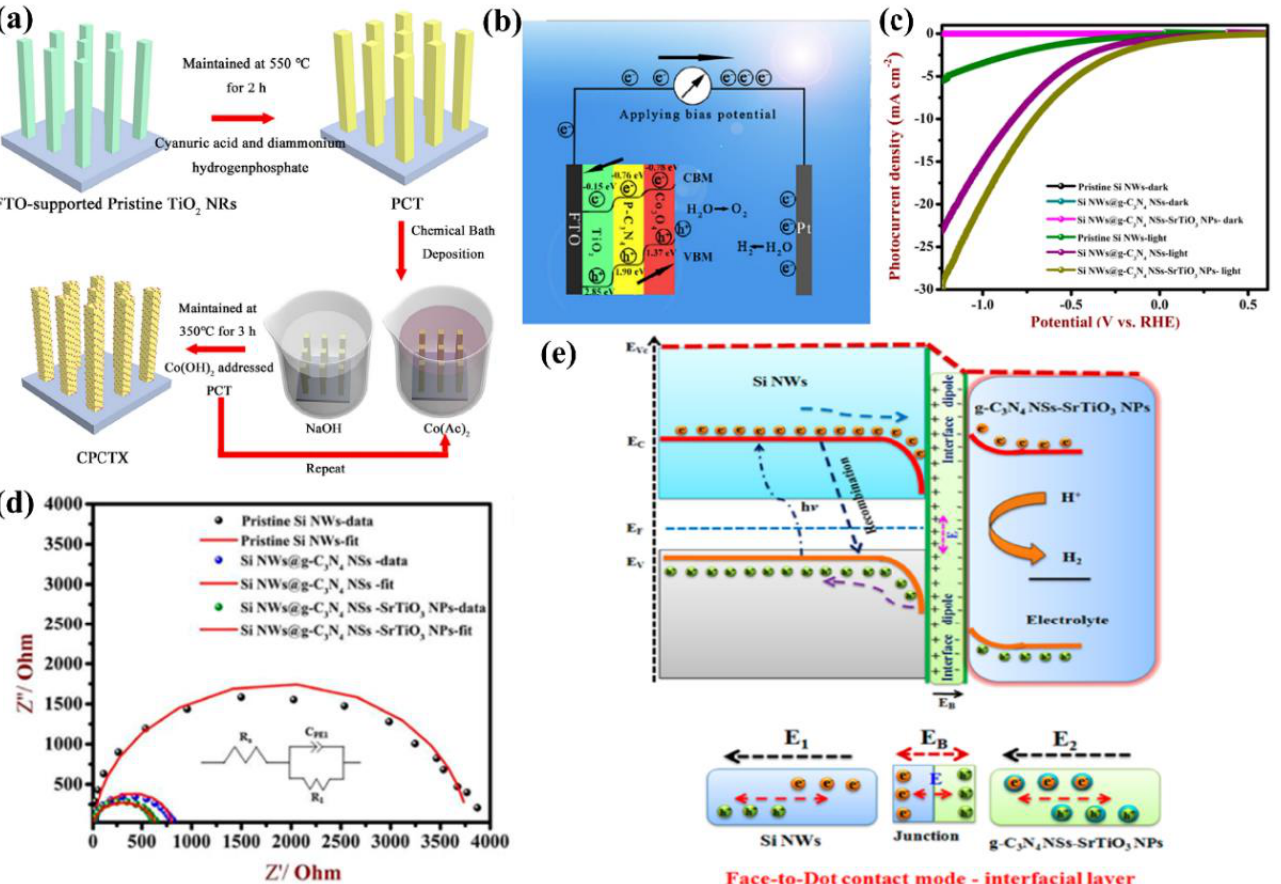
Figure 28. ( a ) Illustration of synthetic routine. ( b ) Schematic diagram for photogenerated charge transfer and separation in composite photoanode. Reprinted with permission from ref. [259] Copyright 2021 Elsevier. ( c ) LSV photocurrent response in 0.5 M Na 2 SO 4 under simulated solar light irradiation. ( d ) EIS Nyquist plots. ( e ) Schematic illustration of charge transfer mechanism and photon-induced water reduction process. Reprinted with permission from ref. [262] Copyright 2019 American Chemical Society.